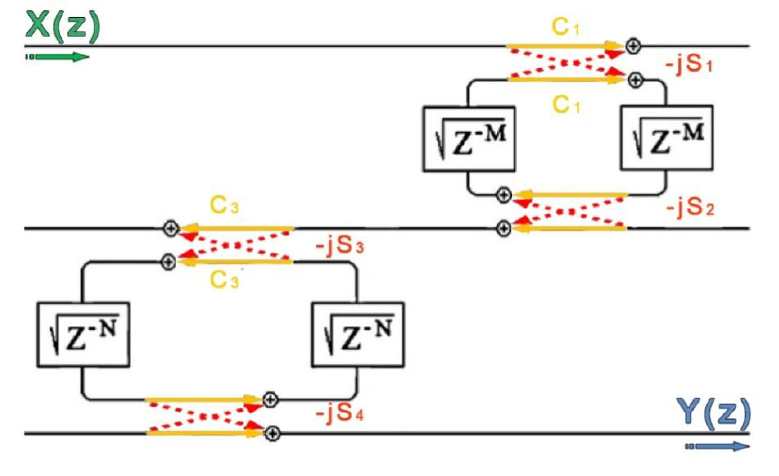
Figure 5. Vernier architecture signal flow graph in the Z-transform